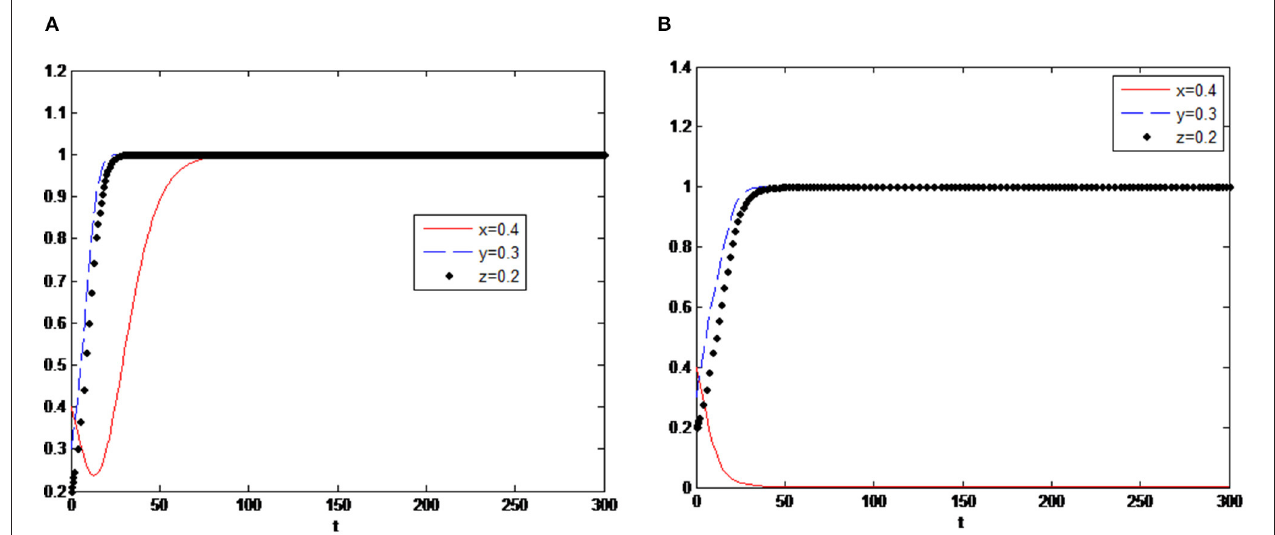
FIGURE 4 | (A) Evolution simulation in case of s 1 < s 2 . (B) Evolution simulation in case of s 1 > s 2